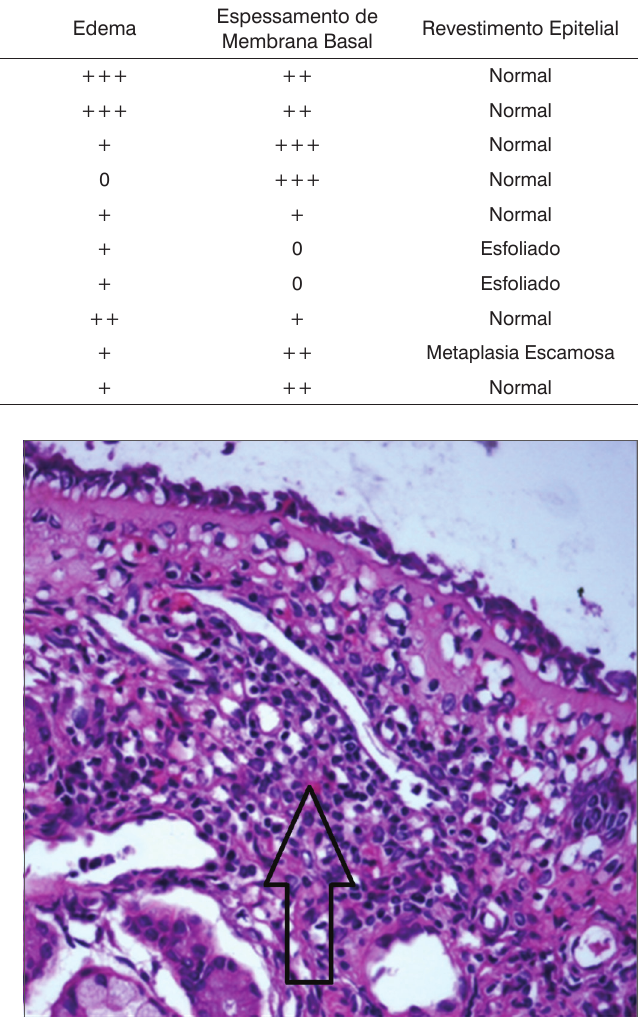
Tabela 2. Análise semi-quantitativa dos achados histopatológicos da mucosa nasal de pacientes com rinite alérgica e sorologia negativa para o HTLV-1 (controles).